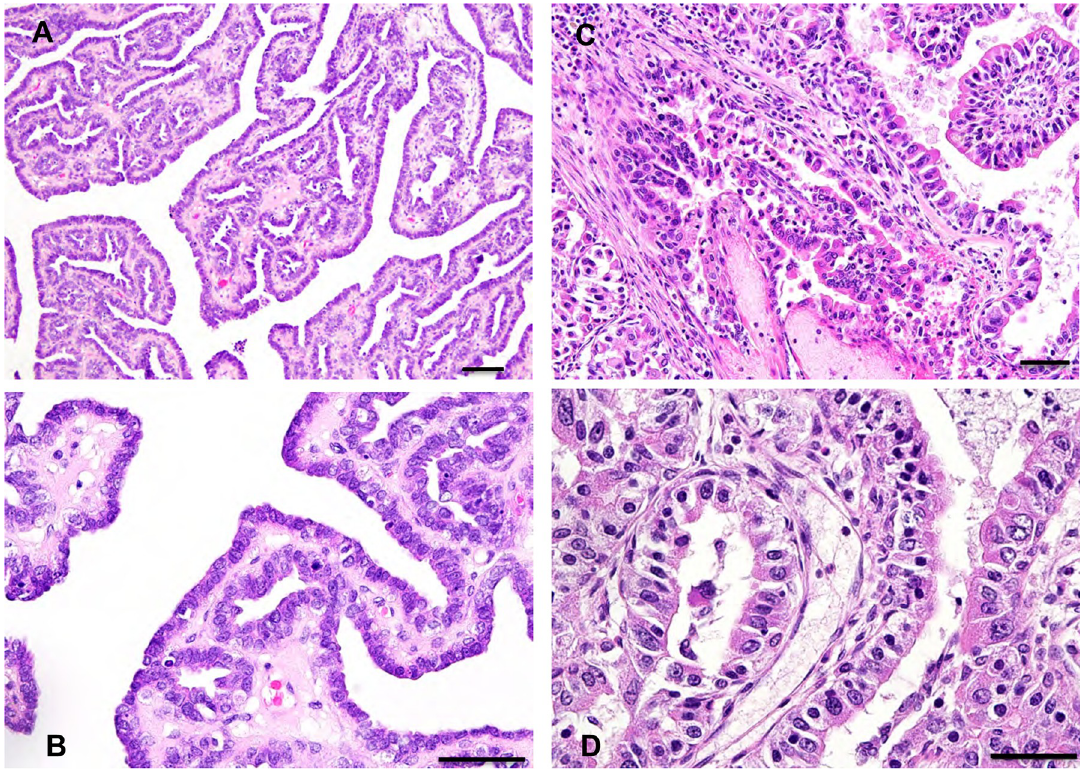
Fig 4. HE staining of tree shrew mammary gland tumors (bar = 100 μ m). Intraductal papillary adenomas (tree shrew No.97, 3 years 11 months old, A, B ) and tubulopapillary carcinoma in tree shrew No.75 (6 years 1 month old, C, D